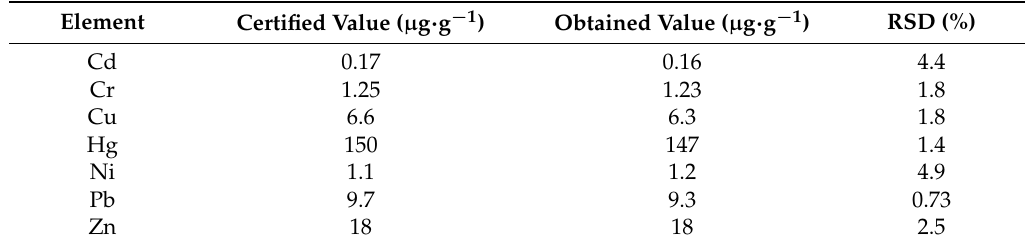
Table 1. Results of accuracy experiments by GBW10020 and precision experiment ( n =